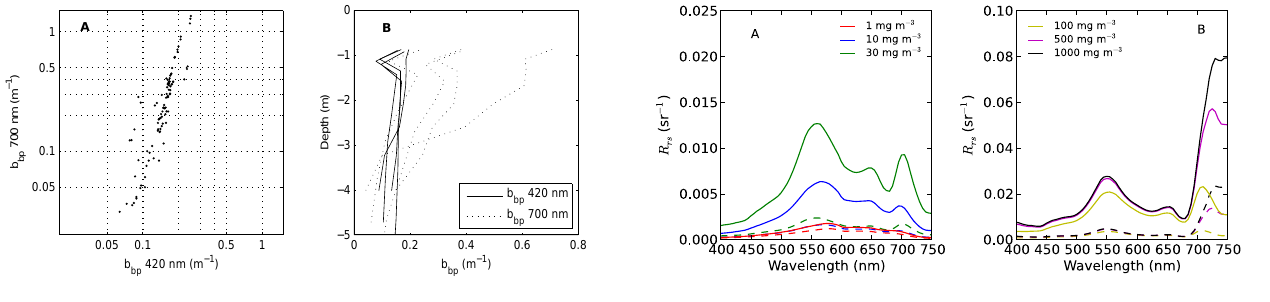
Fig. 8. (A) b bp ( 700 ) vs. b bp ( 420 ) from 11 profiles. Note exponen- tial relationship with log-scaled axes. (B) Five selected depth pro- files with minimum depth of 0.8m. Note that b bp ( 420 ) > b bp ( 700 ) at depth.